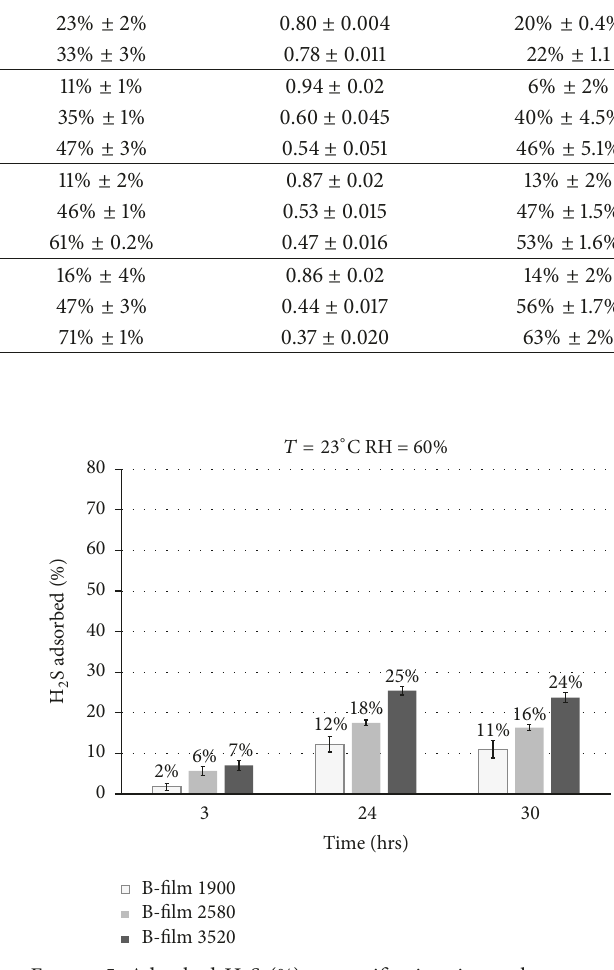
Figure 5: Adsorbed H 2 S (%) at specific time intervals at storage temperature of 23 ∘ C and humidity of 60%. The bag tested was with thefilmsheets inside. Thesurfaceof theinternal film sheetwas equal to 1900cm 2 (B-film 1900), 2580 cm 2 (B-film 2580), and 3520 cm 2 (B-film 3520), respectively. The data reported are the average of the results from three different tests performed at the same